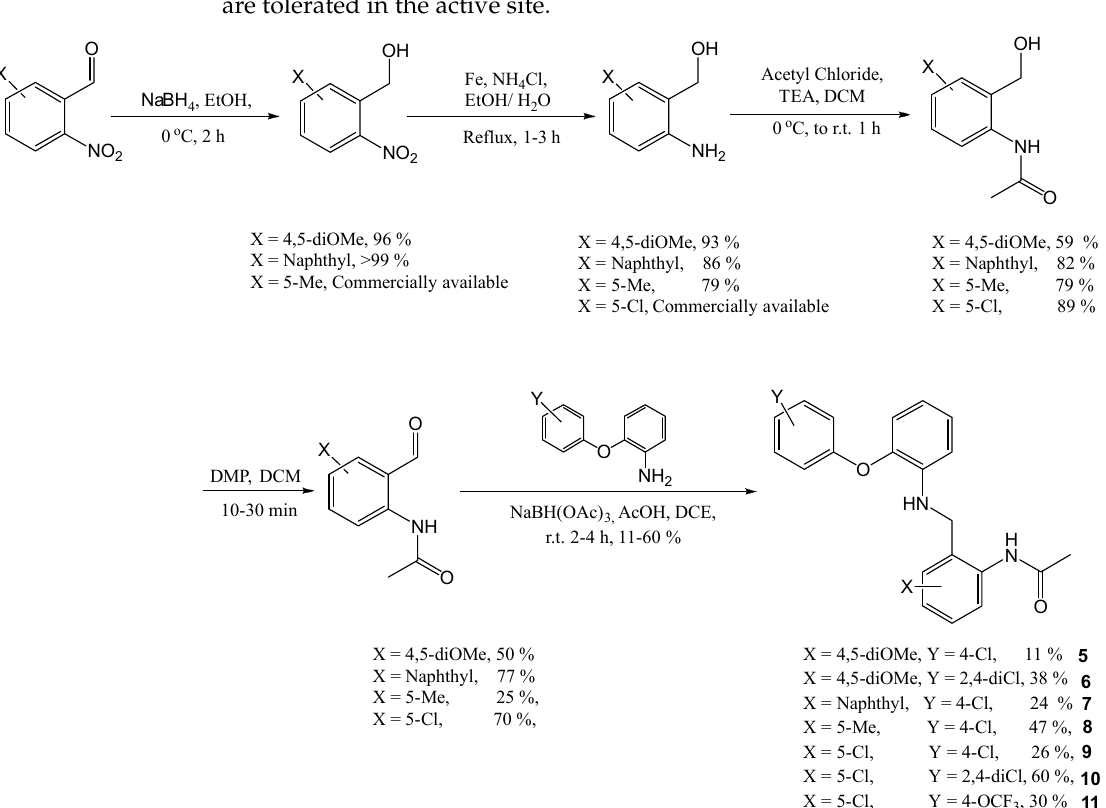
Table 2. Compound list and biological data obtained for analogues based upon 1 , with substitutions around the central aromatic ring. a Results obtained from the TLC assay. Mean of at least two measurements with typically an SD of ±5%. IA (inactive). b Compound 4 was synthesised using a different route, see Scheme 2a. c Compound 1 was synthesised using a different route (see Scheme 1).